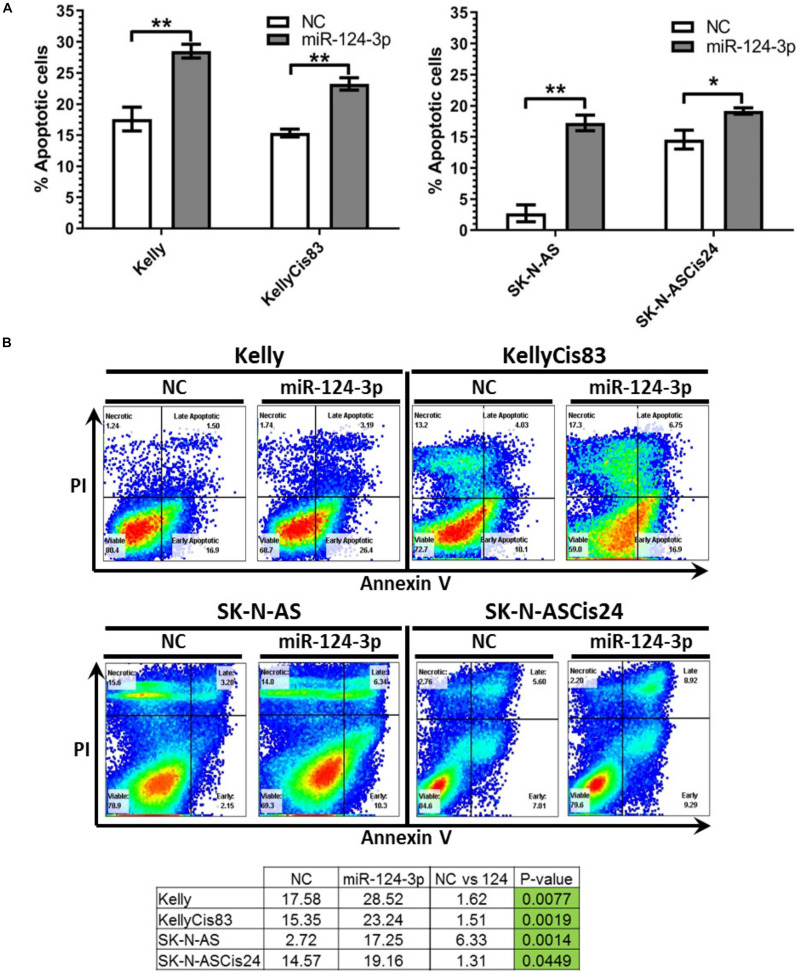
(A) Mean percentage of annexin V-positive Kelly/KellyCis83 and SK-N-AS/SK-N-ASCis24 cells from three independent experiments at 48 h and 96 h, respectively, following transfection with scrambled NC, miR-124-3p mimic or Kiff11. (B) Representative scatter plots of PI vs. Annexin V-FITC staining in one experiment with Kelly/KellyCis83 and SK-N-AS/SK-N-ASCis24. Asterisks indicate statistical significance obtained using unpaired Student’s t-test (*p < 0.05, **p < 0.01, ***p < 0.001, ****p < 0.0001).